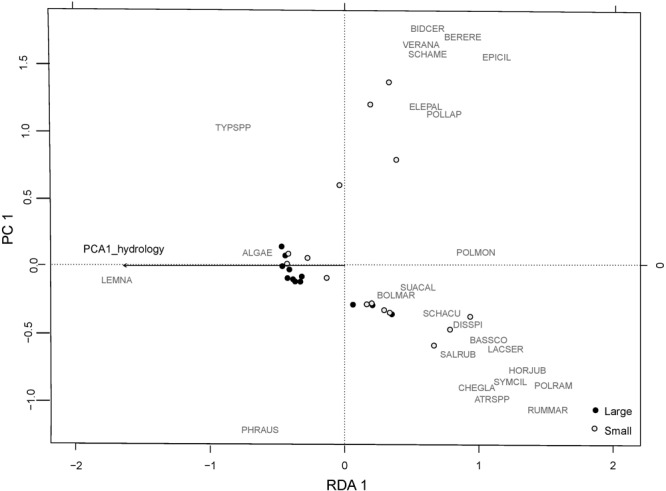
RDA plot of the plant community from 2015 with the PCA1 hydrology overlaid. Large plots are marked by black dots. Small plots are marked by open white dots. Species codes are: ALGAE: algae; ATRSPP: Atriplex spp.; BASSCO: Bassia scoparia; BERERE: Berula erecta; BIDCER: Bidens cernua; BOLMAR: Bolboschoenus maritimus; CHEGLA: Chenopodium glaucum; DISSPI: Distichlis spicata; ELEPAL: Eleocharis palustris; EPICIL: Epilobium ciliatum; HORJUB: Hordeum jubatum; LACSER: Lactuca serriola; LEMNA: Lemna spp.; POLLAP: Polygonum lapathifolium; POLMON: Polypogon monspeliensis; POLRAM: Polygonum ramosissimum; PHRAUS: Phragmites australis; RUMMAR: Rumex maritimus; SALRUB: Salicornia rubra; SCHACU: Schoenoplectus acutus; SCHAME: Schoenoplectus americanus; SUACAL: Suaeda calceoliformis; SYMCIL: Symphyotrichum ciliatum; TYPSPP: Typha spp.; VERANA: Veronica anagallis-arvensis.